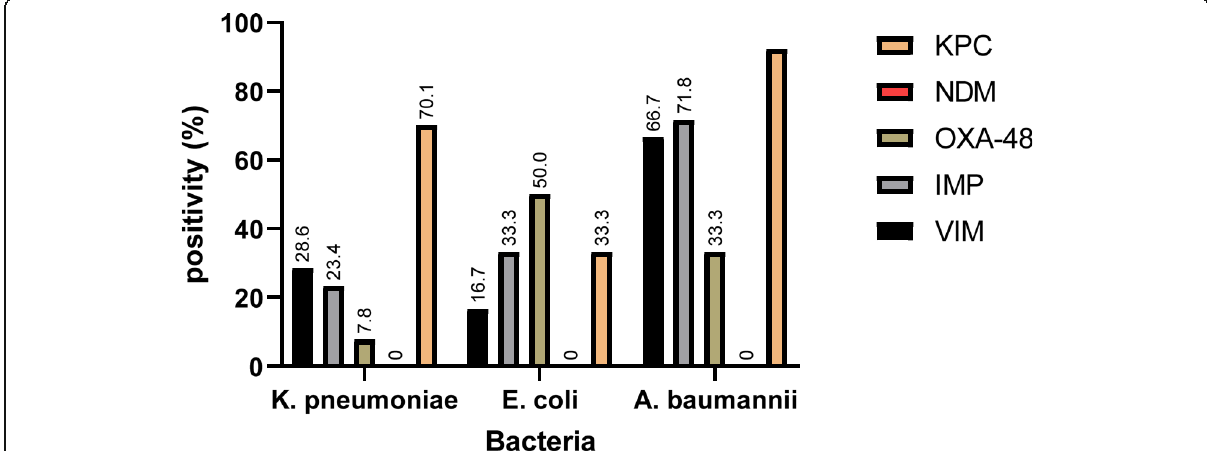
Fig. 2 PCR carbapenemase screening results of 122 carbapenem-resistant clinical isolates of Acinetobacter baumannii , Klebsiella pneumoniae , and Escherichia